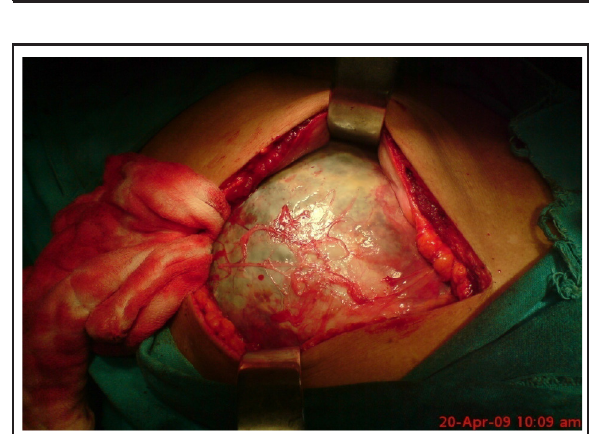
Figure 1. CT Scan of the abdomen showing cyst.